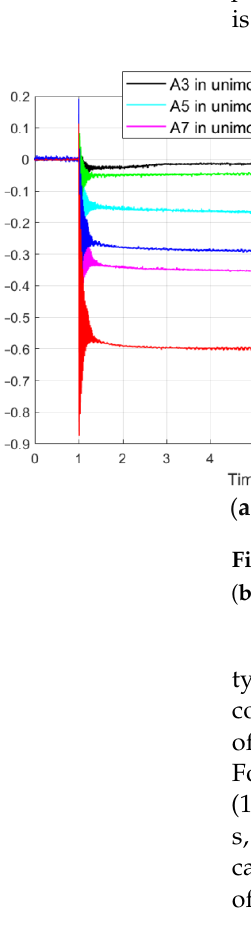
Figure 10. Displacements of measurement point A12 in unimorph and bimorph: ( a ) for control signals 50 V and 100 V; ( b ) for control signals 150 V and 200 V; ( c ) for control signals 250 V, 300 V and 350 V; ( d ) for control signals 400 V, 450 V and 500 V.